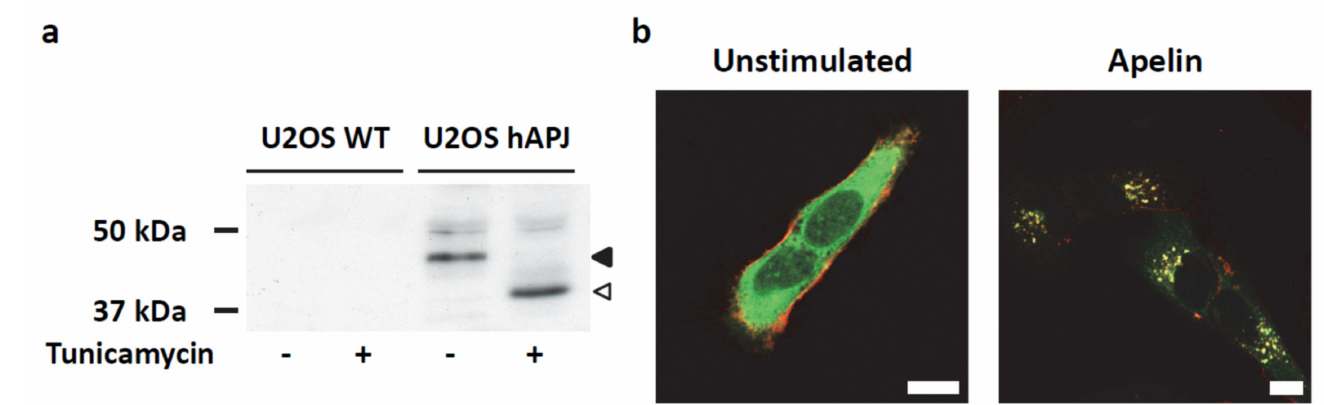
Figure A2. Validation of the antibody directed against the apelin receptor. ( a ) U2OS cells, stably overexpressing apelin receptor or untransfected, were assessed for APJ expression by Western blot (solid triangle). To confirm that the band corresponds to APJ, cells were pretreated for 20 h with tunicamycin to block glycosylation of the receptor. As expected, the APJ band was close to 42 kDa (open triangle). ( b ) Immunofluorescence on unstimulated (left) or apelin-stimulated (right panel) U2OS cells overexpressing APJ and β -arrestin 2-GFP using the anti-APJ antibody. Green channel illustrates the localization of β -arrestin 2-GFP, whereas the red channel shows APJ labeling, highlighting the expression of APJ at the membrane in unstimulated cells and the colabeling of APJ and β -arrestin 2-GFP in apelin-stimulated conditions. Scale bar, 10 µ m.